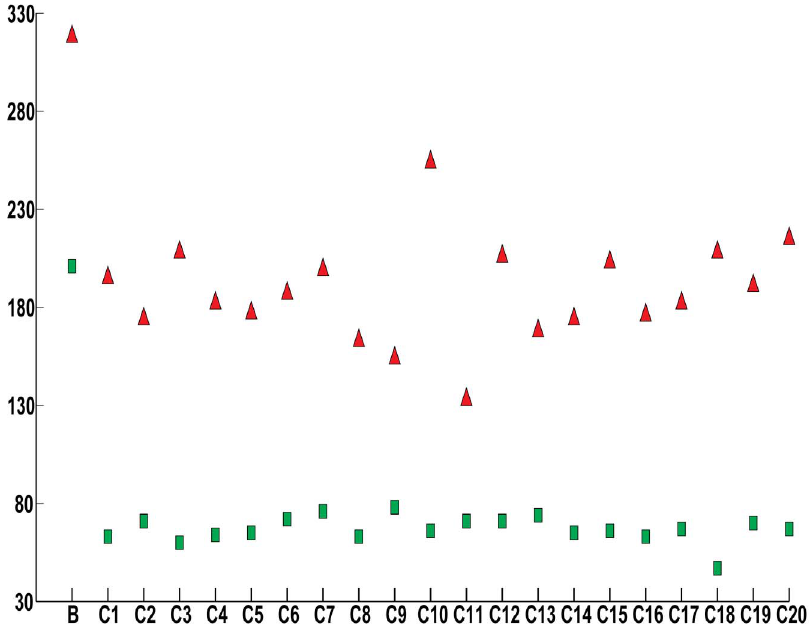
Figure 3. Number of repeats per dataset. The total number of tandem repeats (red triangles) and G-quadruplex (green rectangles), sequences per CNV breakpoint (B) and control (C1-C20) datasets are